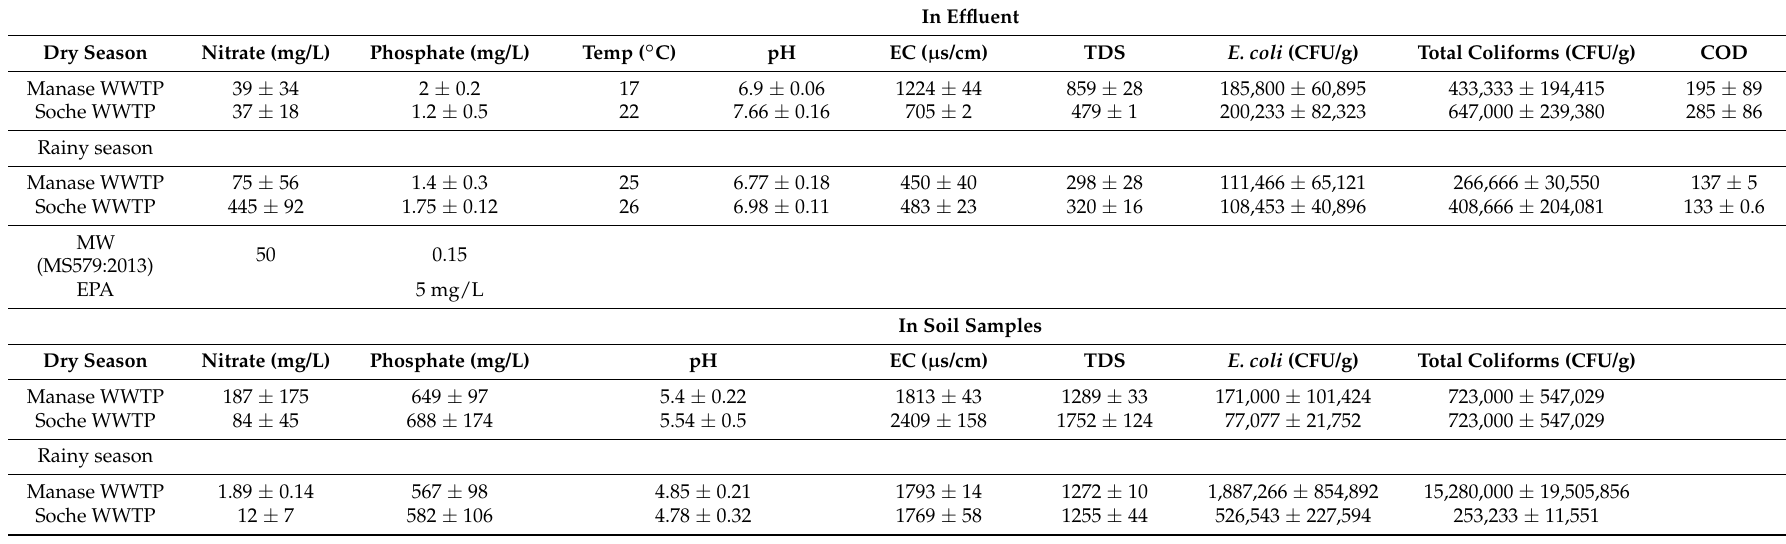
Table 1. Mean and standard deviation of nitrate, phosphate, physical, and biological parameters in effluent and soil at Manase and Soche